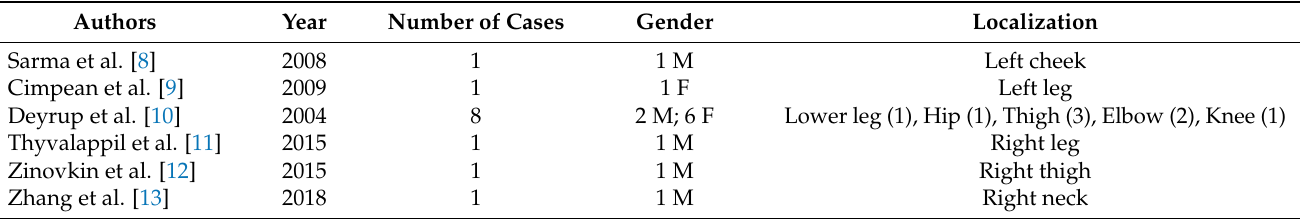
Table 2. PDMT described in the